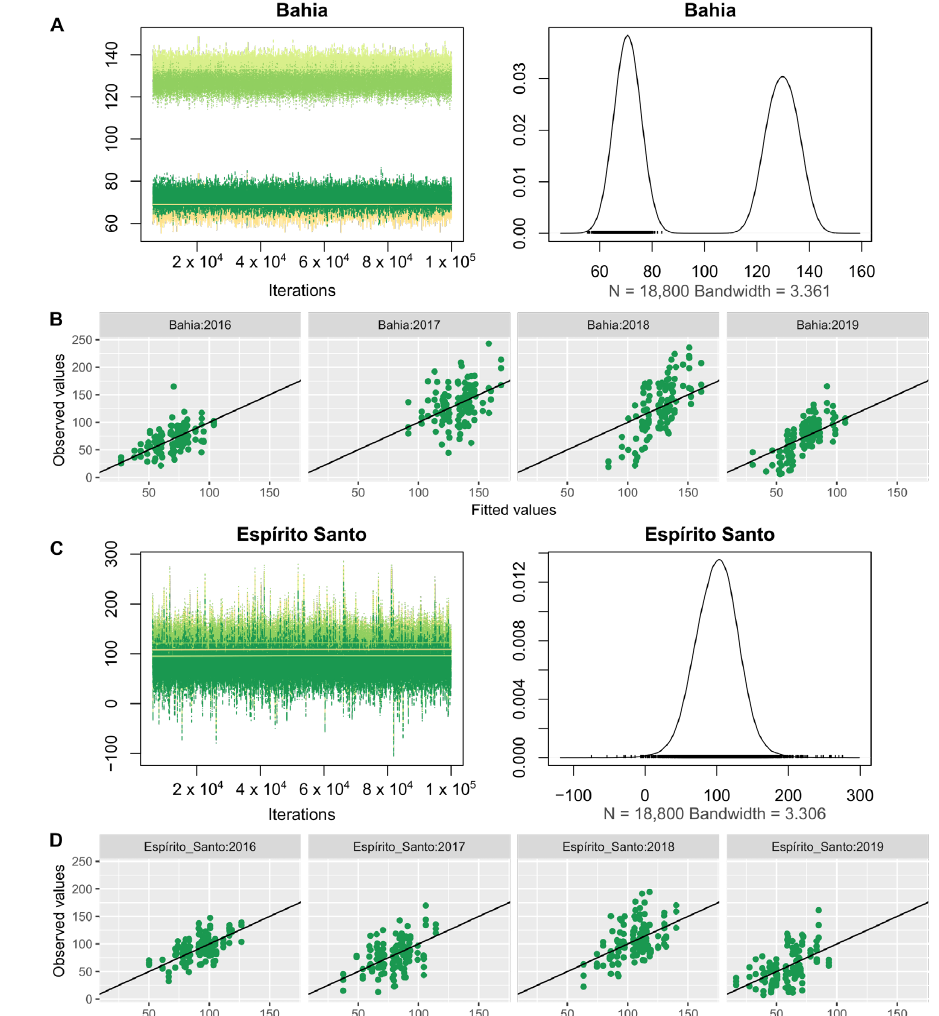
Figure 1. Time series of the chains of the four crops within the Bahia location, and probability density function curve of the chains ( A ). Observed versus predicted values for the four crops in the Bahia location ( B ). Time series of chains of the four crops within the Espírito Santo location, and probability density function curve of the chains ( C ). Observed versus predicted values for the four cultures at the Espírito Santo location ( D ).